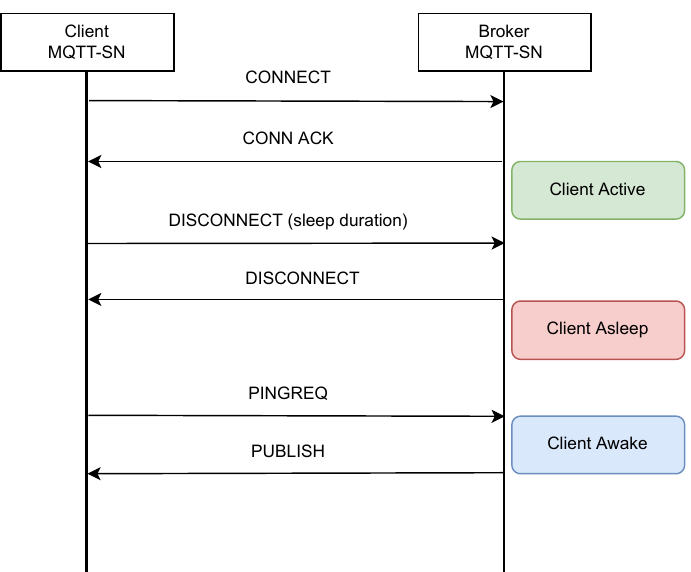
Figure 22. MQTT-SN sleeping mechanism diagram.